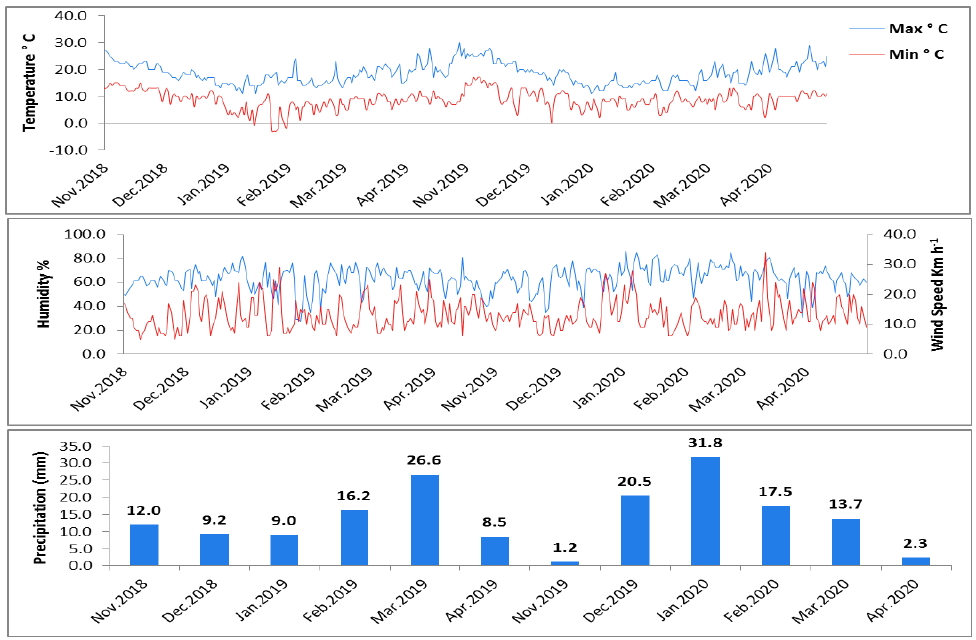
Figure 1. Monthly meteorological during the two winter growing seasons.